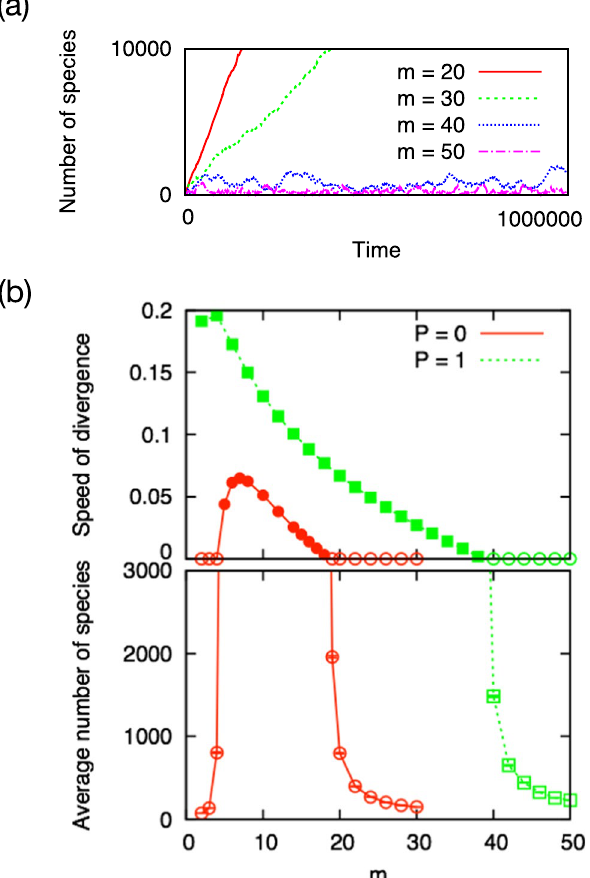
Figure 2. The critical behavior of emergent systems with P = 0 or P = 1. ( a ) Temporal evolution of total number of species N ( t ) for P = 1. It diverges in time if the sum of in-degree and out-degree of each new species is small ( m = 2 M = 20 and 30), and it keeps fluctuating in a finite size for larger M (2 M = 40 and 50). ( b ) Phase diagram of the growth behavior for P = 0 (red) and P = 1 (green). (top) Speed of divergence. (bottom) Average number of species. Filled symbols represent the systems with positive speed N ( t )/ t . The bidirectional model (circles) involves a transition from the diverging phase to the finite phase between m = 38 and 40. The critical point = = = = m M 2 39 CP CP 1 1 is almost twofold of that of the unidirectional model (triangles) = . = m 18 5 CP 0